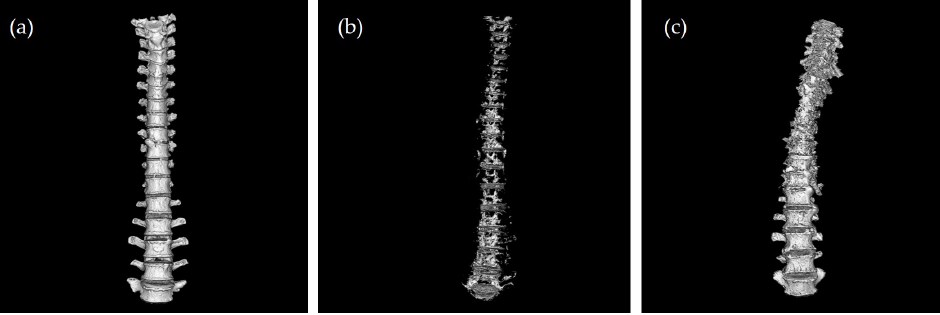
Figure 1. Examples of images that were included and excluded. ( a ) Included image: There was no defective or putrefied gas in the vertebrae body. ( b ) Excluded image: Most of the vertebrae bodies were replaced by putrefied gas and the shape of the vertebrae was unclear. ( c ) Excluded image: This is the case of death after burning. Although the lumbers remained, most of the thoracic vertebrae were defective.